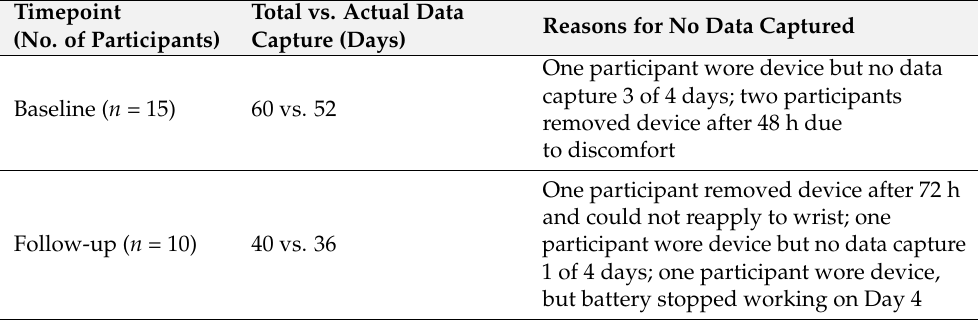
Table 2. Total tracker data capture across all participants before and after AVR.